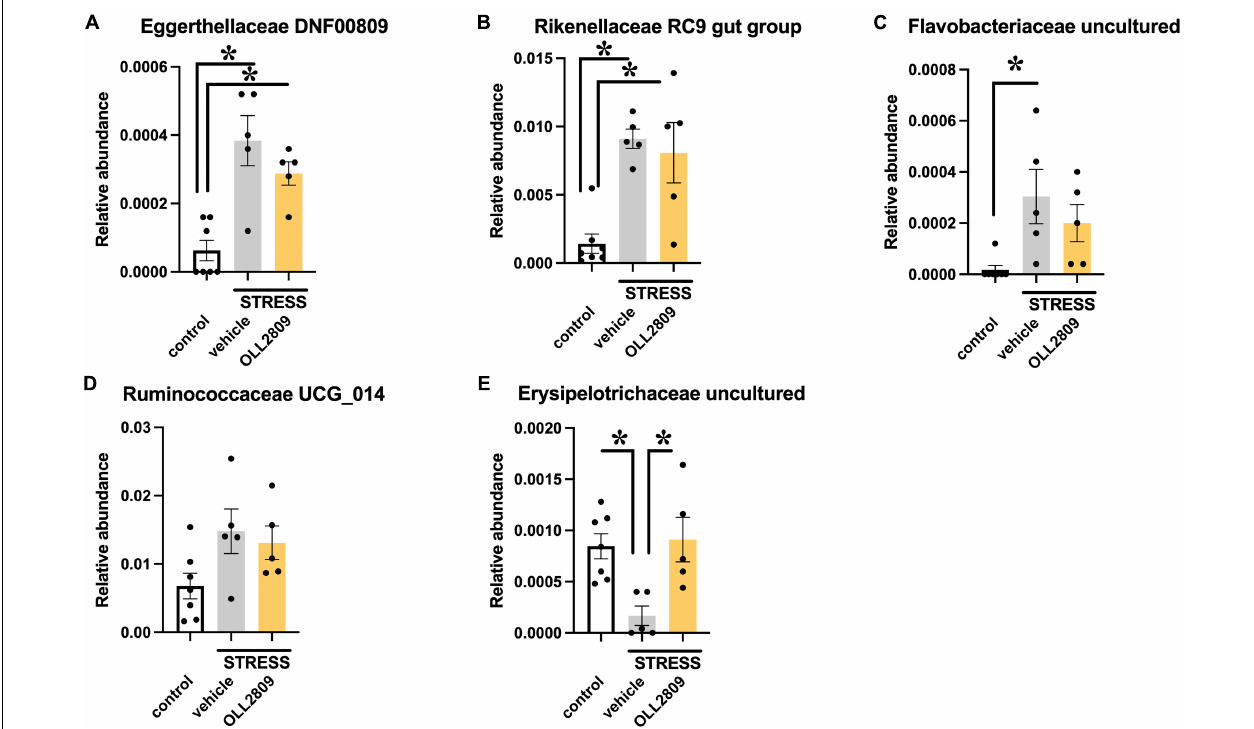
FIGURE 6 | Effects of Lactobacillus paragasseri OLL2809 administration on relative abundance of gut microorganisms that showed significant correlation with immobility time in the forced swim test. (A) Eggerthellaceae DNF00809, (B) Rikenellaceae RC9 gut group, (C) Flavobacteriaceae uncultured, (D) Ruminococcaceae UCG_014 and (E) Erysipelotrichaceae uncultured. Each bar indicates the mean ± S.E.M. * p < 0.05, Tukey–Kramer test. Each plot represents the number of mice. Control, n = 7; stress + vehicle, n = 5; stress + OLL2809, n =